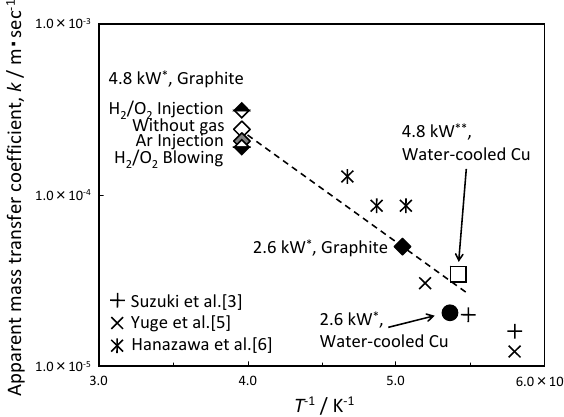
Figure 8. Arrhenius plot of apparent mass transfer coeffi- cient (melted by * filament type EB, ** gas-discharge EB).